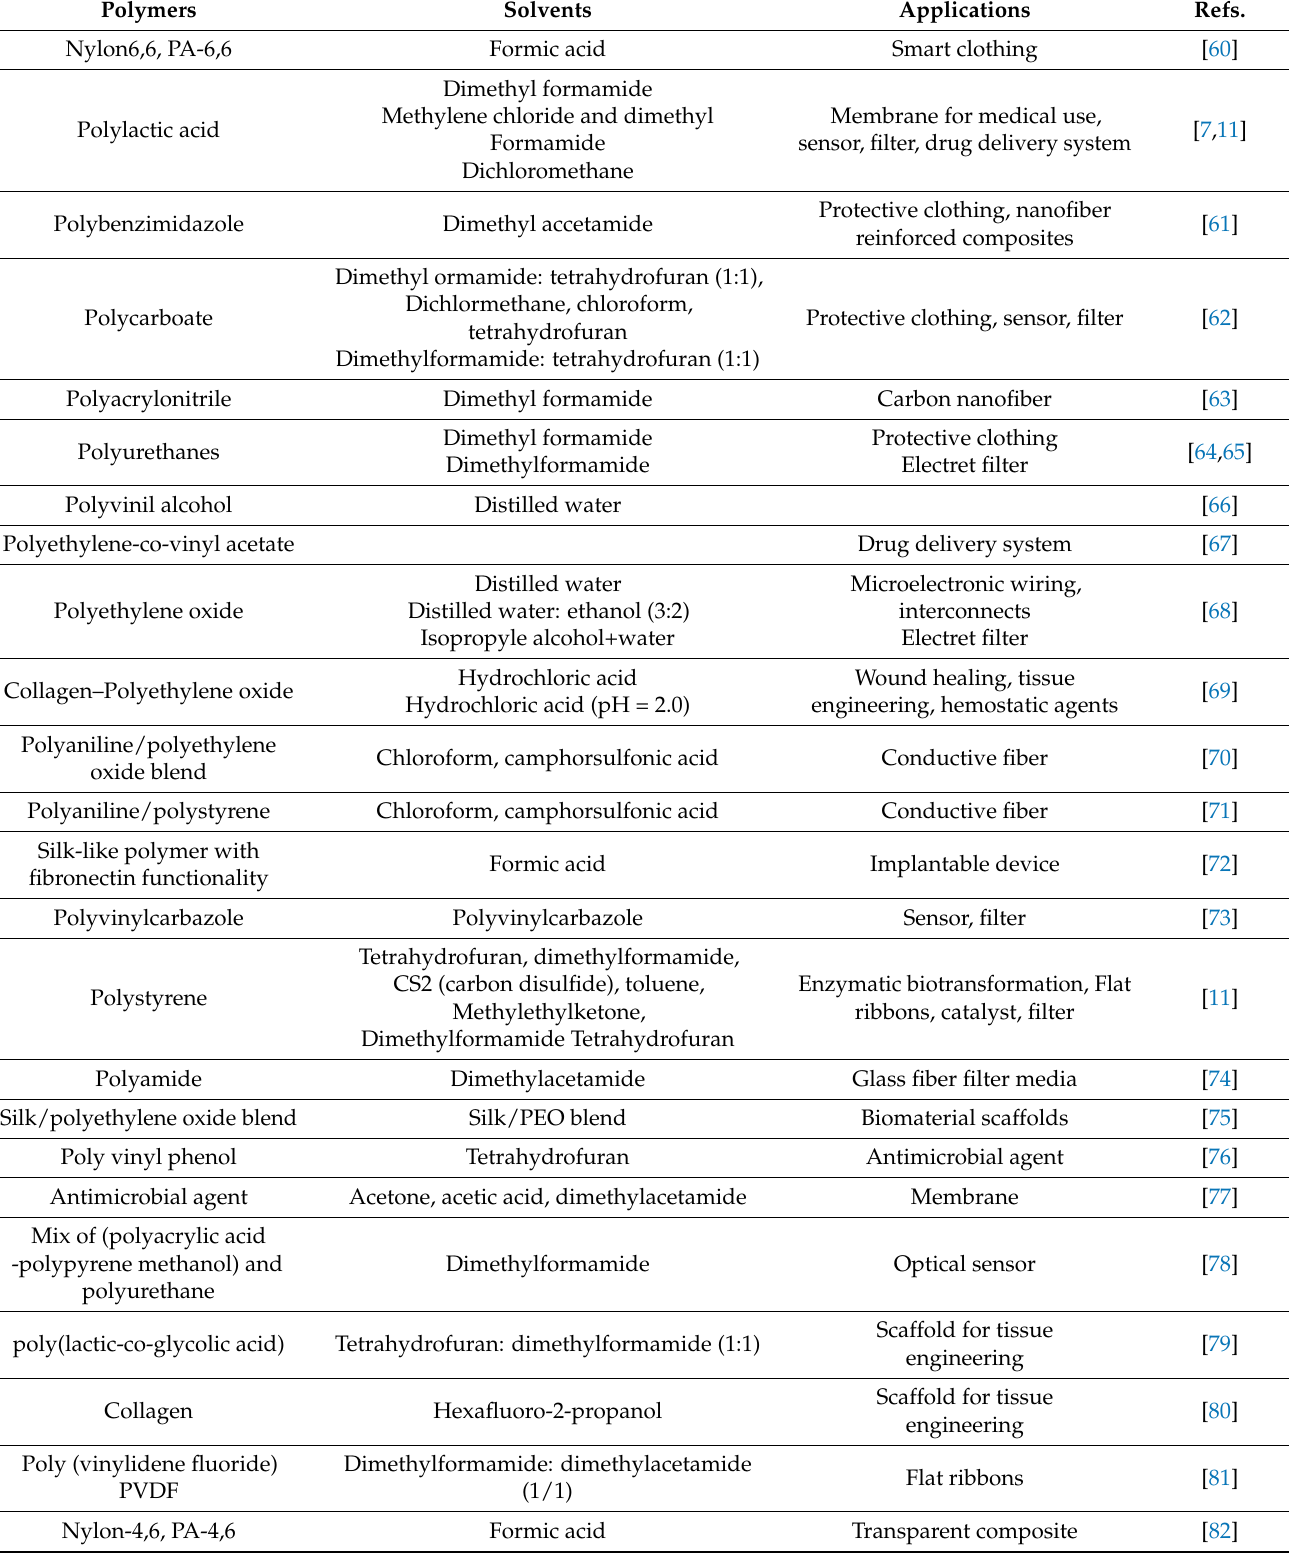
Table 3. Polymers used in electrospinning, and their characterization techniques and